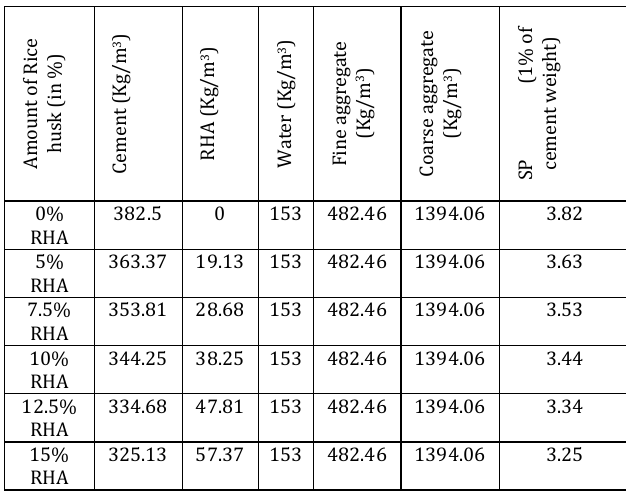
Table 4: Mix proportions of Rice Husk